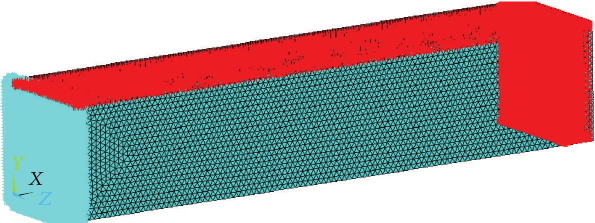
Figure 6: Applied uniformly distributed load on the top longi- tudinal surface and compressive loading distributed over one end (shown in red) of a typical porous cantilever beam model subjected to combined loading. The other end of the model is fixed for all degrees of freedom (shown in